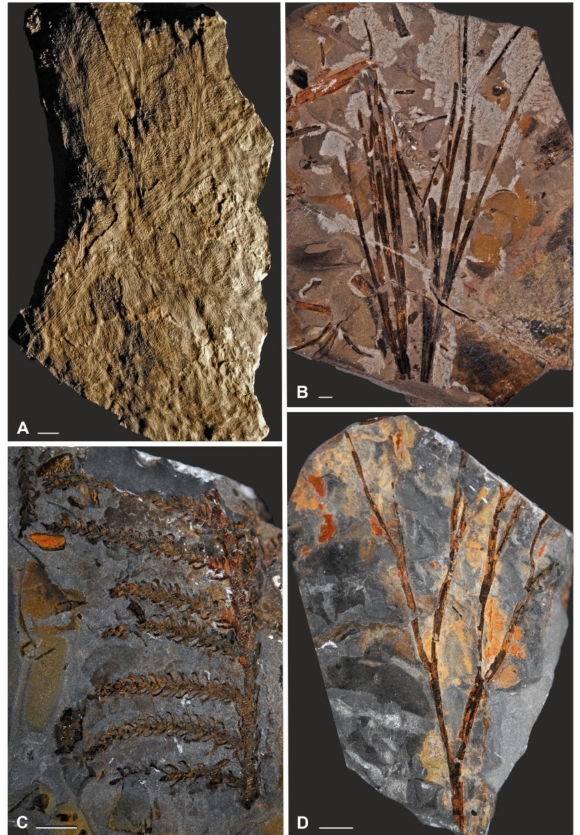
Figure 19. Plant remains from the Souss Basin, Morocco: ( A )— Odontopteris subcrenulata pinna with pinnules, CDUE TaV3 X1; ( B )— Sphenobaiera sp. several times bifurcating leaf without recognizable venation, CDUE Ta1 13d5; ( C )—walchian conifer leafy fragment with tiny needle-like leaves, CDUE Ta1 13d5/1; ( D )— Sphenobaiera sp. up to four times bifurcating leaf, FG T5 3.3.12; scale bars: 5 mm; photo: S.